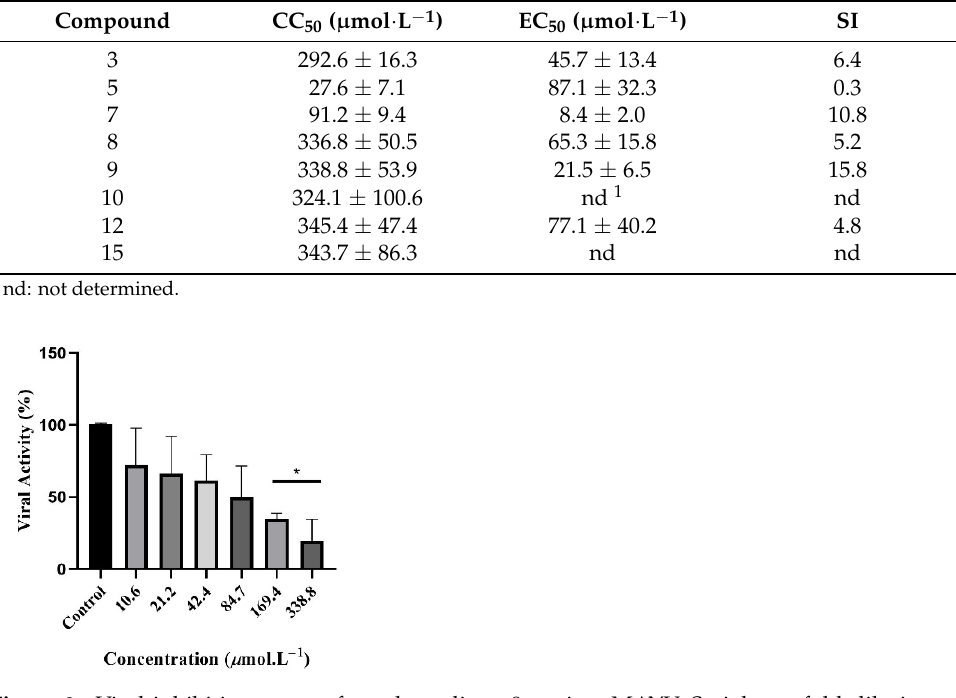
Figure 3. Viral inhibition assay of xanthenodione 9 against MAYV. Serial two-fold dilutions of com- pound 9 and a MAYV suspension (MOI 1) were mixed and incubated at 37 °C for 1 h. * p <